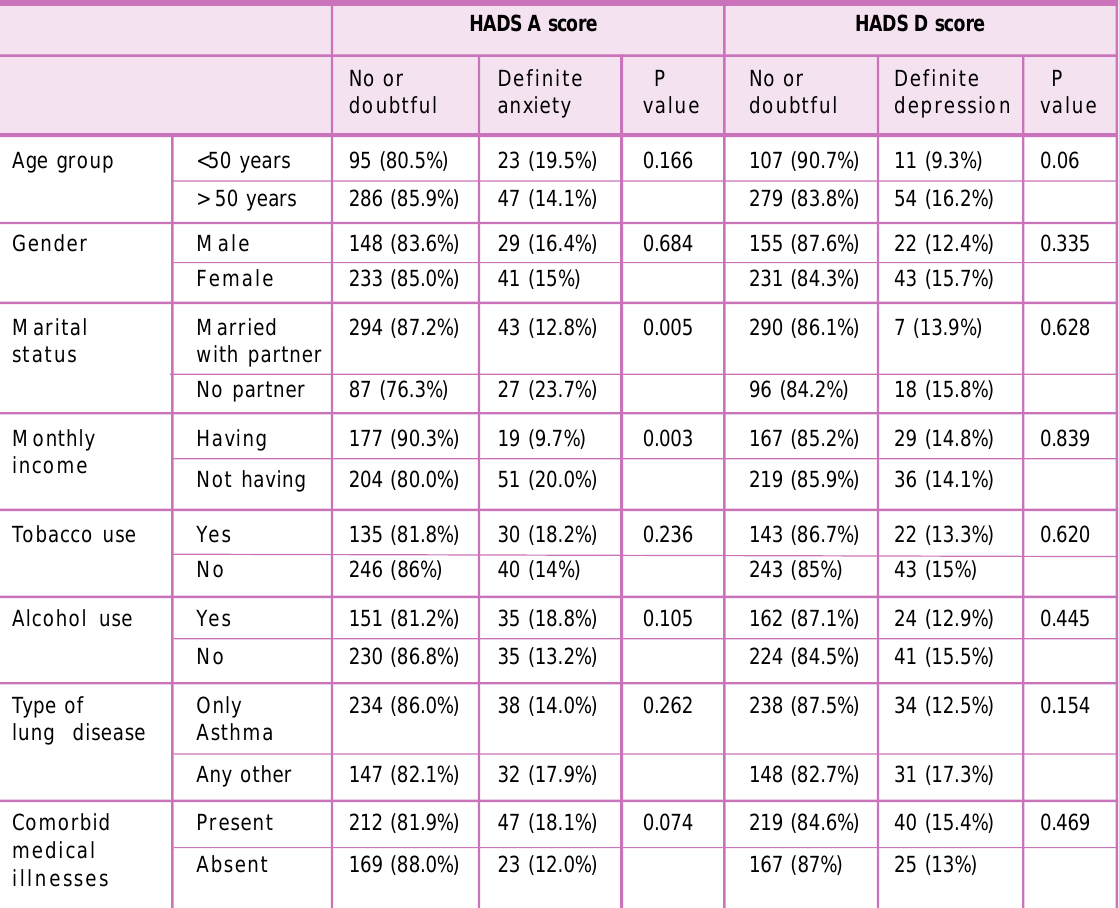
Table 3. Associations between HADS score level and different variables of